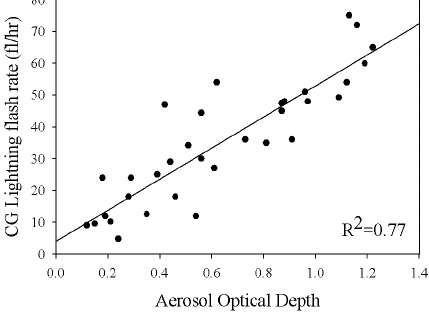
Figure 6. Scatterplot of CG lightning flash count with aerosol opti- cal depth (AOD).